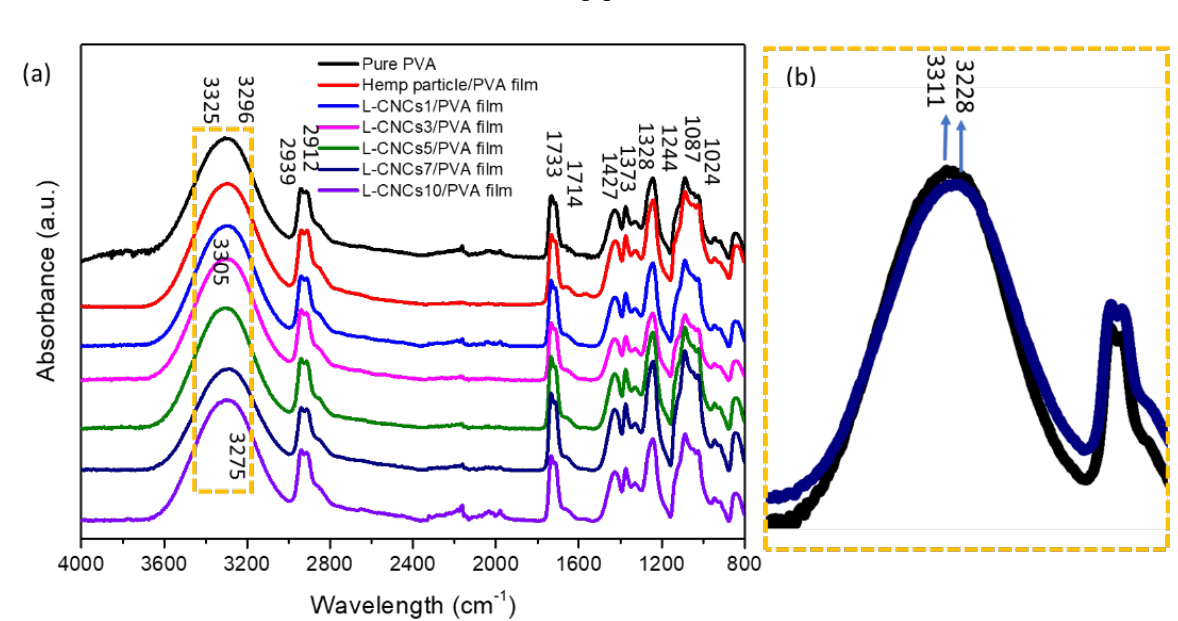
Figure 5. ( a ) FTIR spectrum of pure PVA, hemp particle/PVA and L-CNCs/PVA films. ( b ) Zoom image of pure PVA and L-CNC S 7/PVA films between 3700 cm −1 and 2800 cm −1 shown in ( a ).